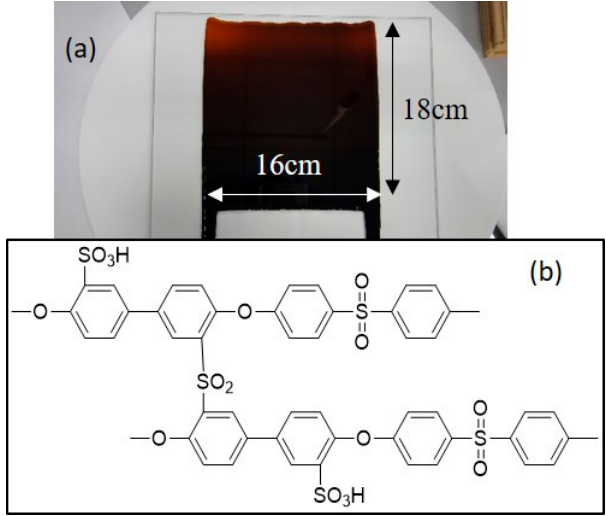
Figure 1. ( a ) Image of a crosslinked sulfonated polyphenylsulfone (CSPPSU) membrane on a glass plate and ( b ) chemical structure of a CSPPSU.